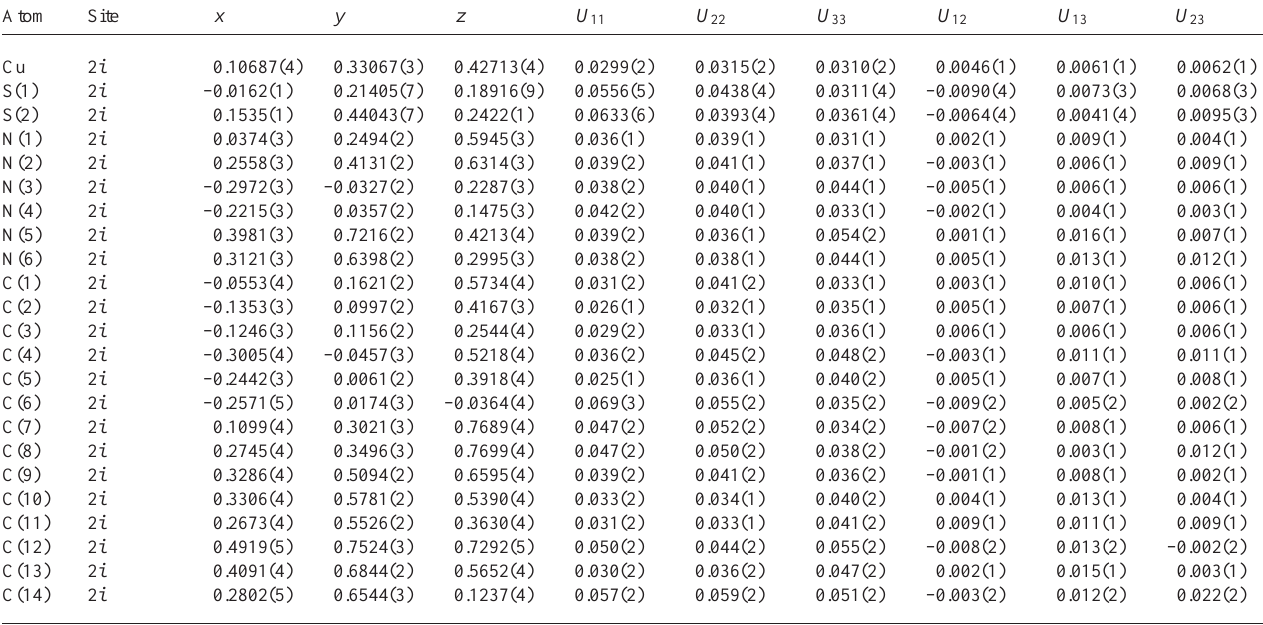
Table 3. Atomic coordinates and displacement parameters (in Å 2 )